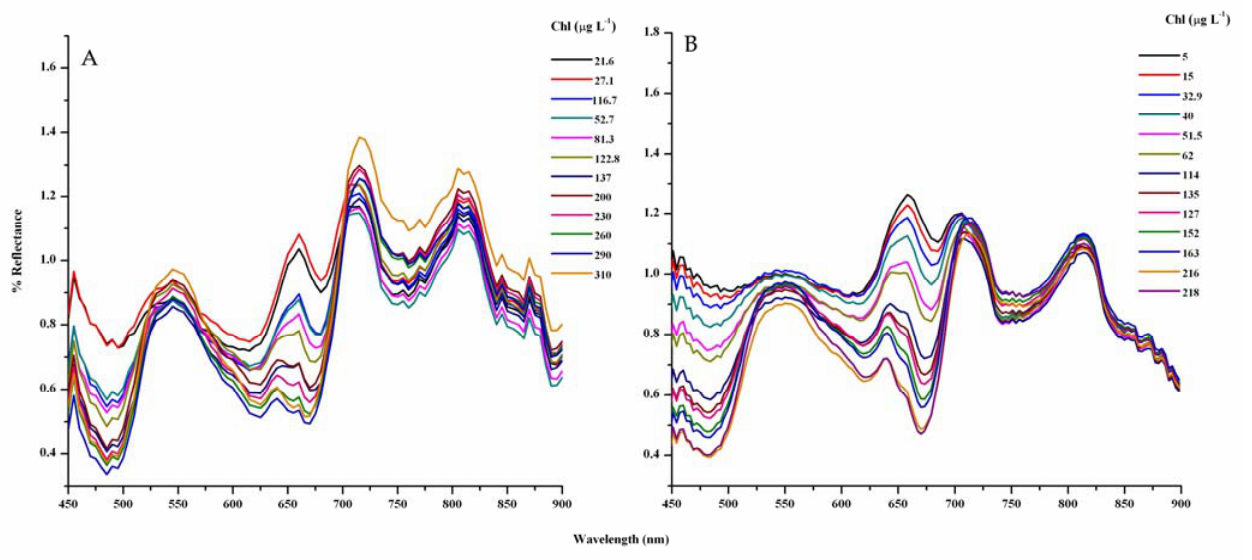
Figure 4. Effect of varying green algae concentrations on (A) Synechocystis and (B) Anabaena reflectance